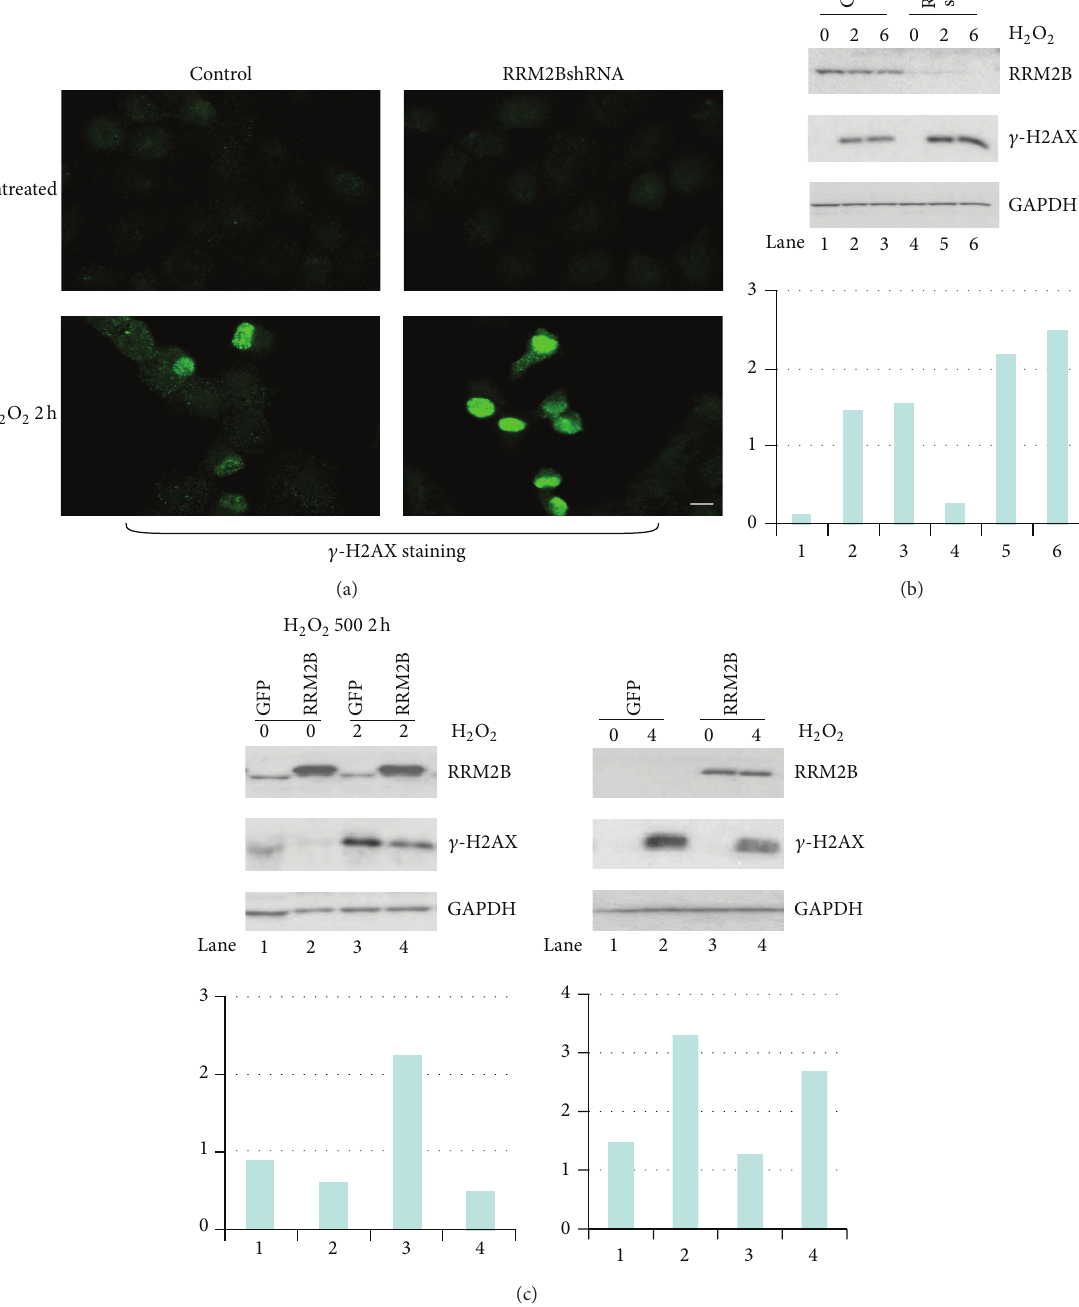
Figure 2: RRM2B functions in H 2 O 2 -mediated DNA damage resistance in p53-deficient cells. (a) H1299 stable cells were treated with 500 𝜇 M H 2 O 2 for 2 hours where applicable for immunofluorescence assay analysis with anti- 𝛾 -H2AX antibody. (b)-(c) Two pairs of cell lines expressing control vectors, RRM2BshRNA and RRM2B expressing vector, were treated with H 2 O 2 and harvested at different time points for Western blots analysis with indicated antibodies. ( 𝑛 = 2 ) Image J was used to normalize 𝛾 -H2AX expression to